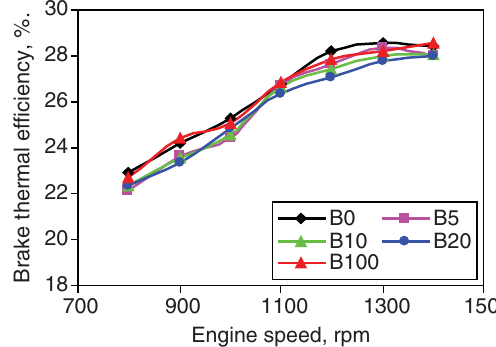
Fig. 6. The effect of the tested fuels on brake power as a function of the engine speed